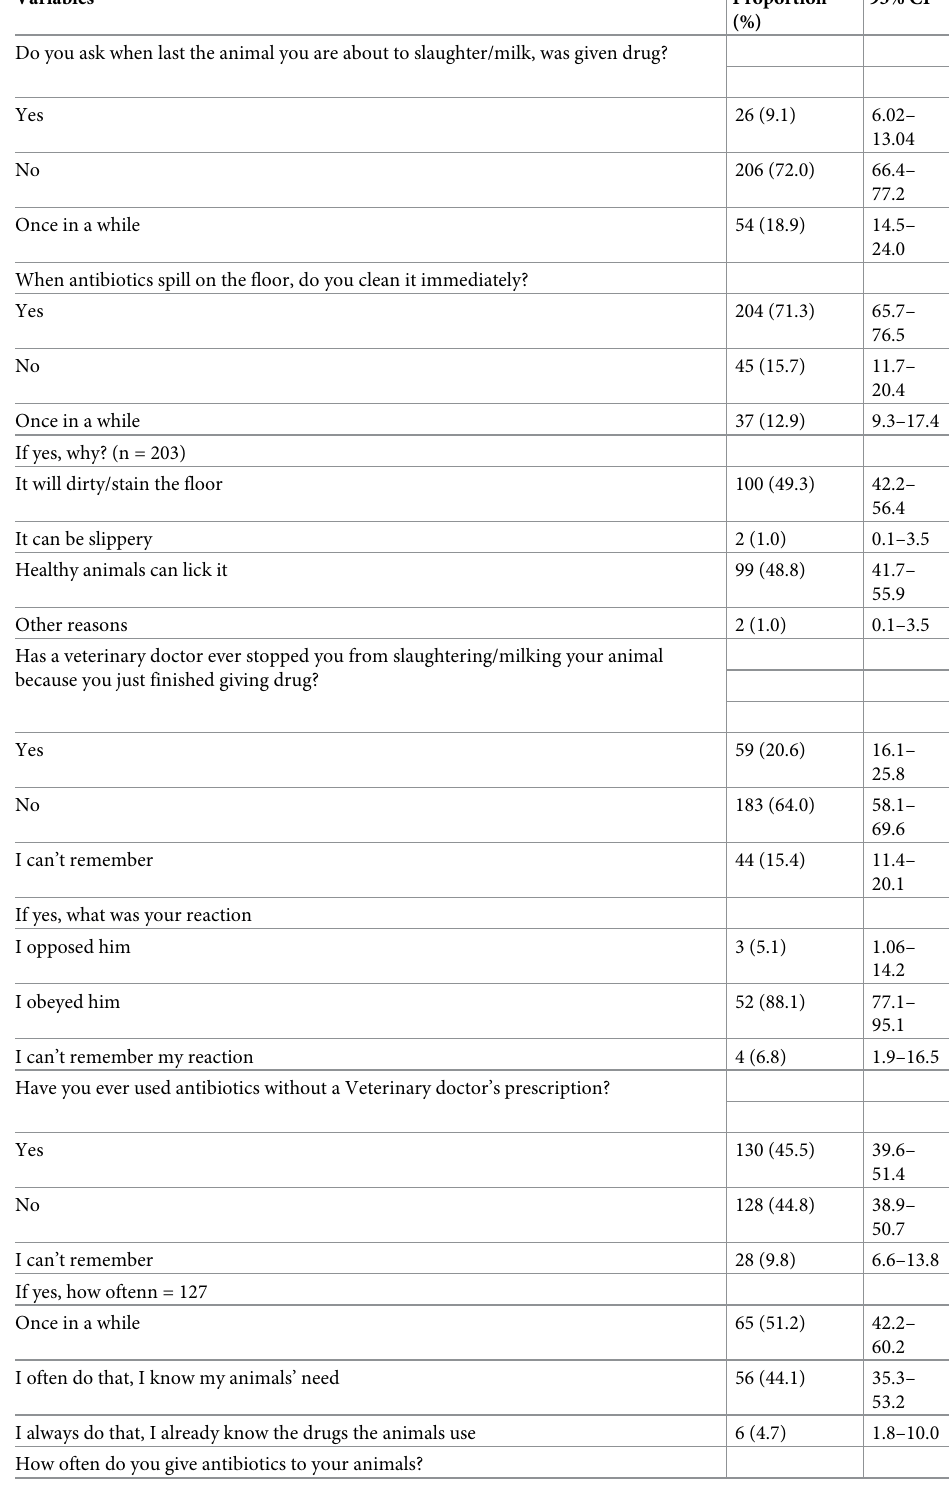
Table 3. Practices of participants regarding antibiotic residues in meat and milk in Kwara